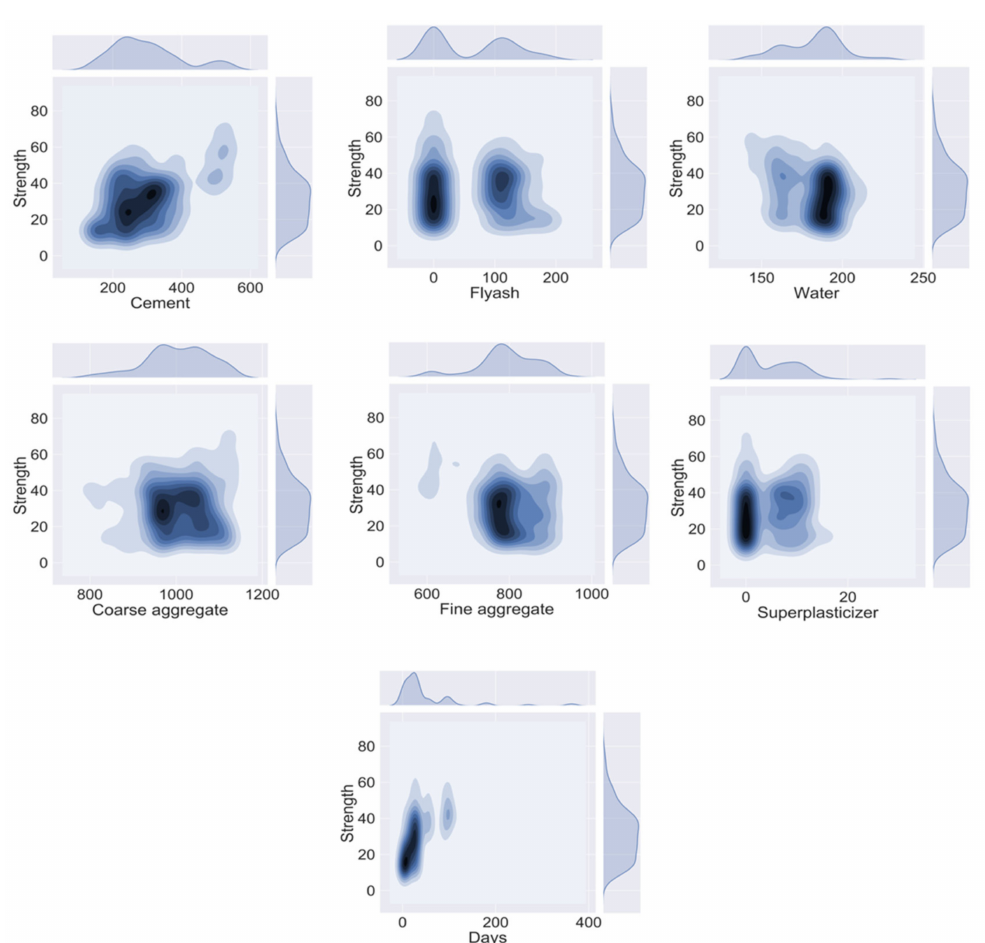
Figure 3. Contour plots indicating the concentrations used in analyzing compressive